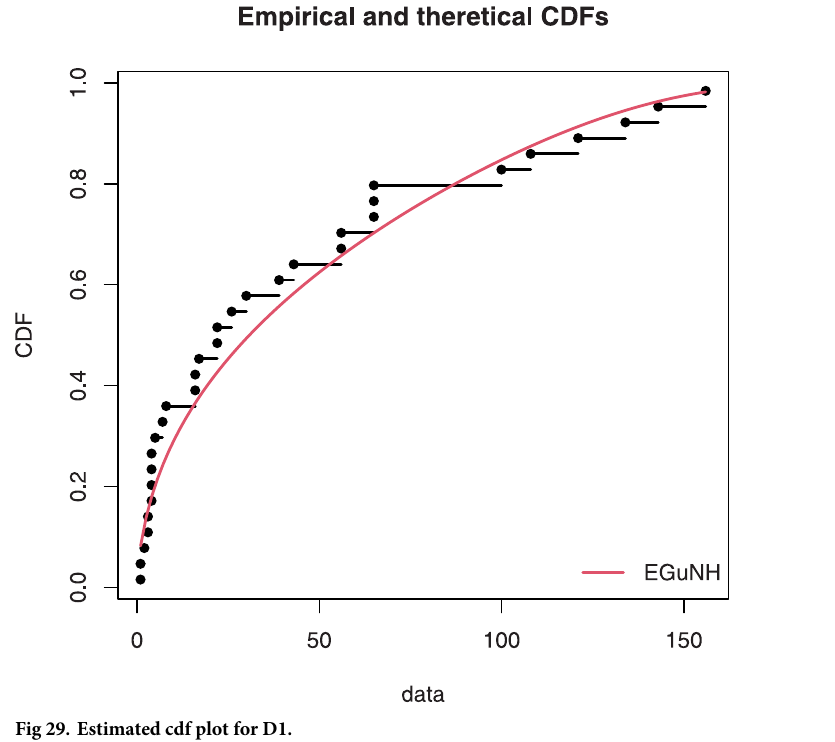
Fig 29. Estimated cdf plot for D1.